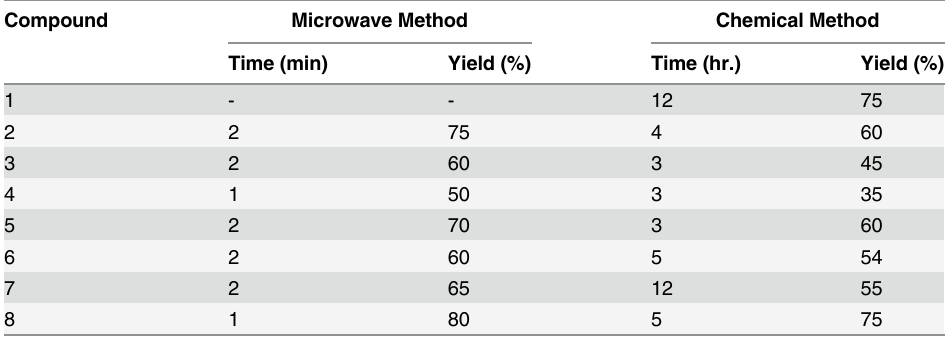
Table 1. Comparison between the microwave-assisted and chemical methods of synthesis in terms of yield and time.